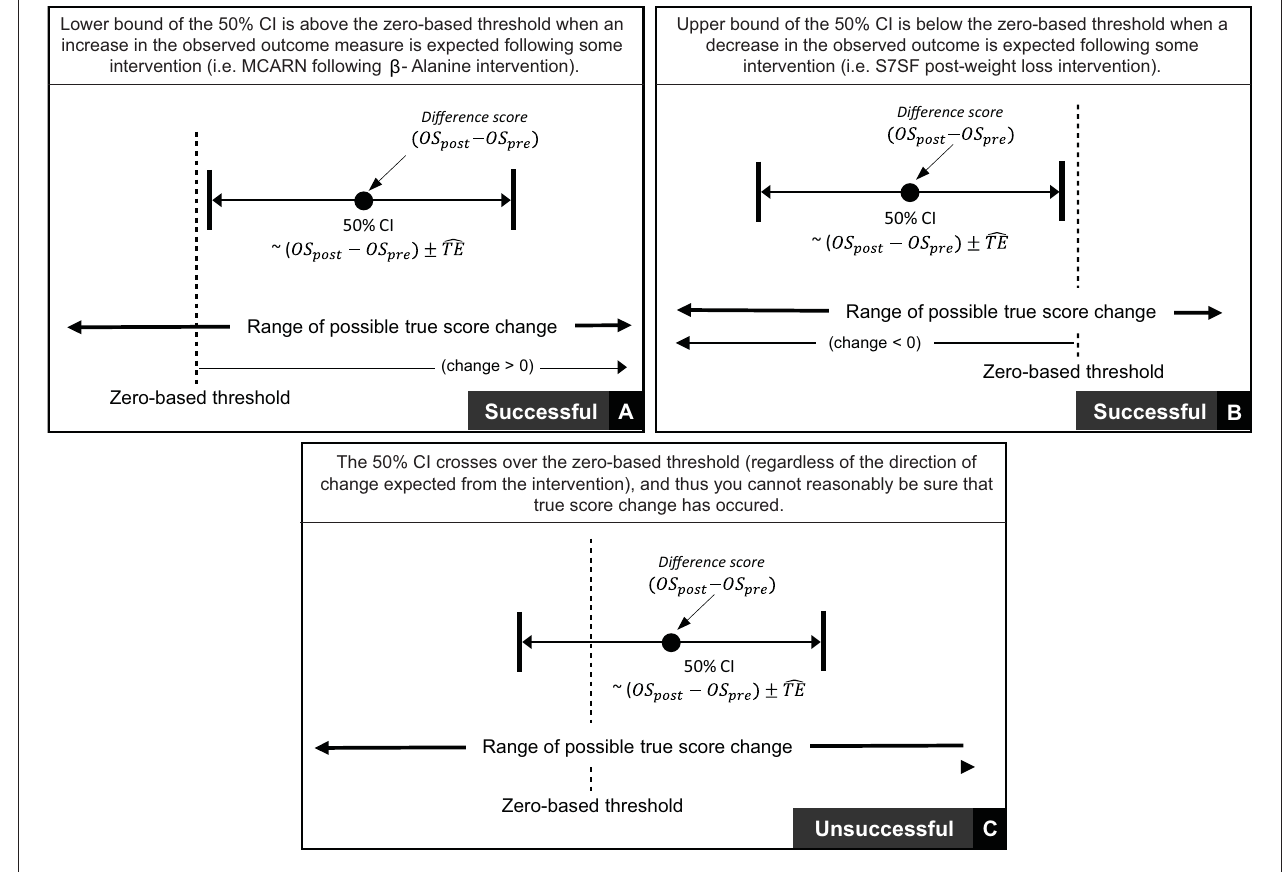
FIGURE 4 | Interpretation of true score change confidence intervals using zero-based